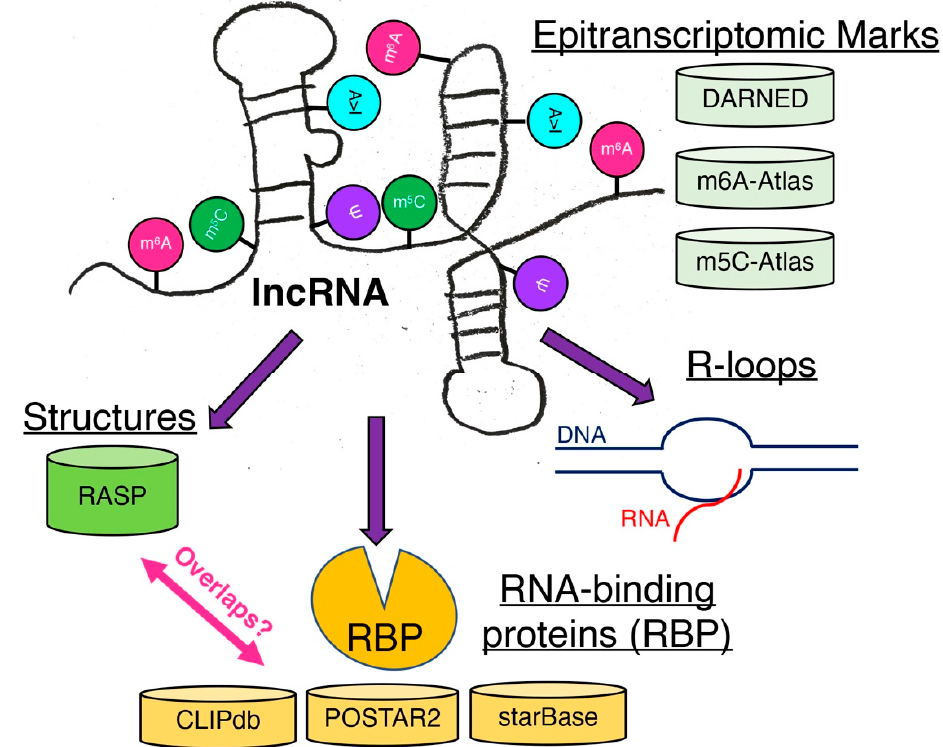
Figure 4. Possible modifications of lncRNAs. These epitranscriptomic marks affect the structures of lncRNAs as well as their binding to RNA-binding proteins (RBPs) and the formation of R loops. Some known databases are listed to facilitate further bioinformatic analysis to connect the information.